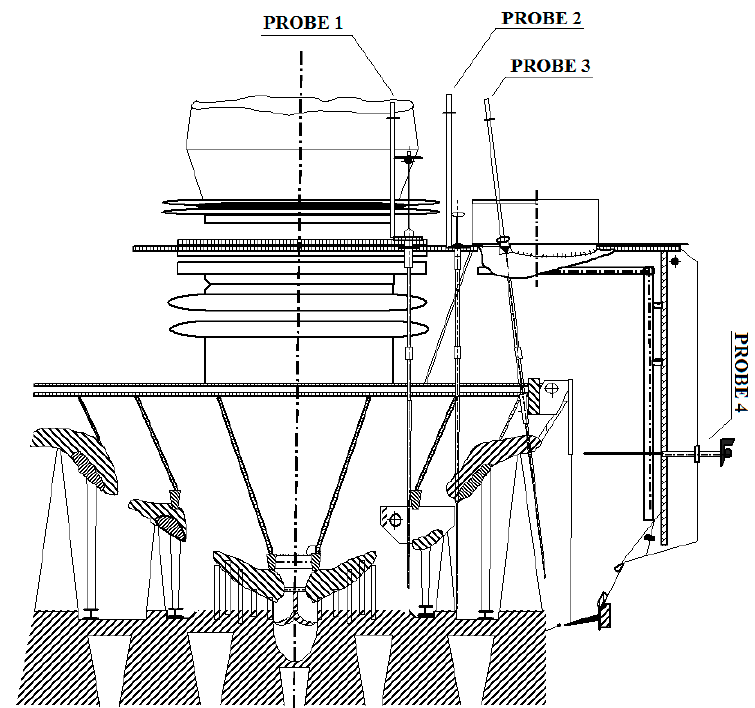
Figure 1. View of the flow part in LPC of a 360 MW steam turbine.